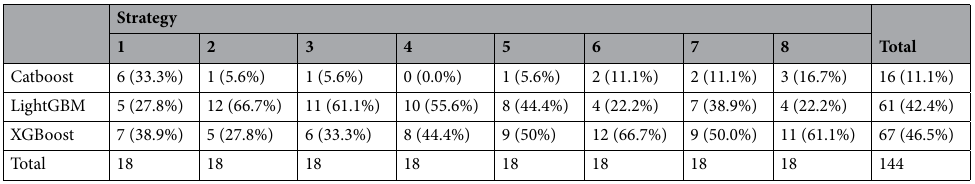
Table 2. Algorithm with the best predictive performance per